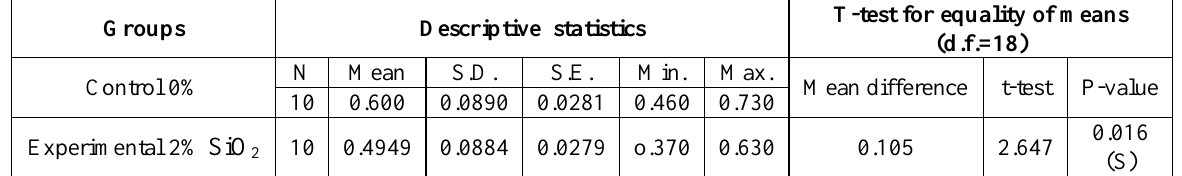
Table 5: Descriptive summary and T-test for water sorption (mg/cm 2 ) Descriptive statistics Groups